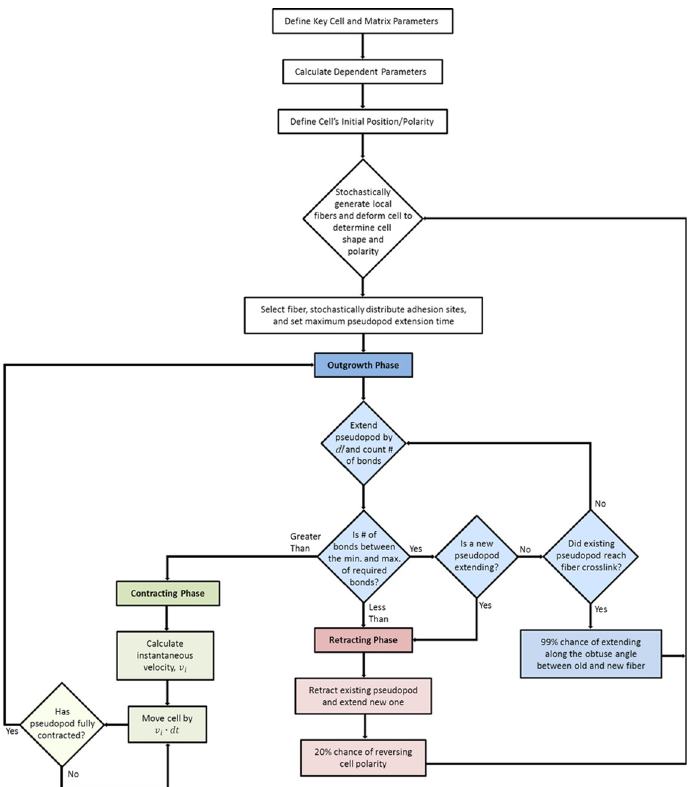
Fig 9. Flow chart for migration algorithm. Blue boxes represent the outgrowth phase, green boxes represent the contracting phase, and red boxes represent the retracting phase.